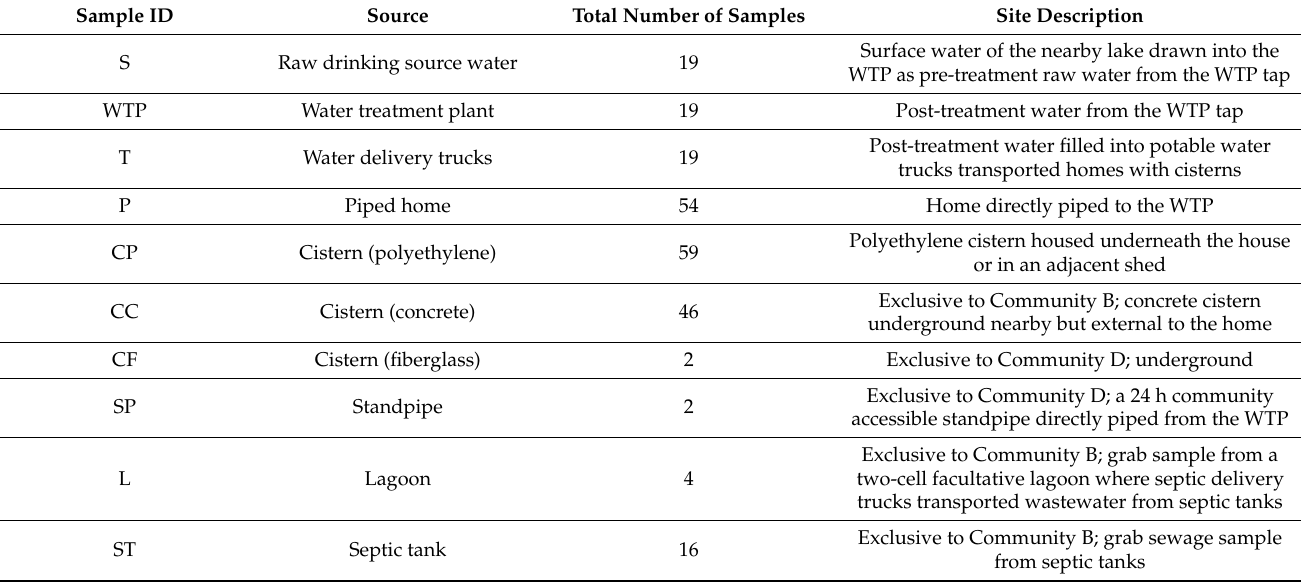
Table 1. Sample ID, source and site description of water samples, collected from pre- and post- treatment DWDS and fecal sources between July 2017 and October 2018, used in this